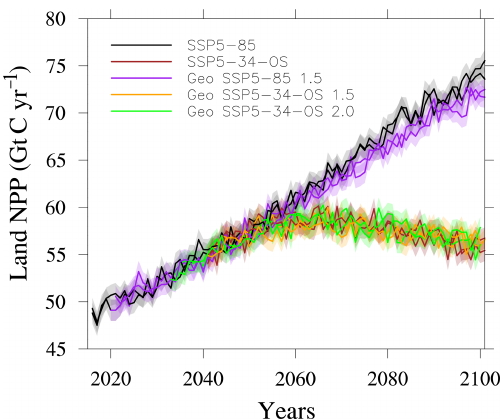
Figure 7. Annual land-accumulated NPP (GtCyr − 1 ) in baseline and SAG scenarios and ensemble members (different colors are in- dicated in legend). The shaded areas are significant with 95% con- fidence, assuming normally distributed